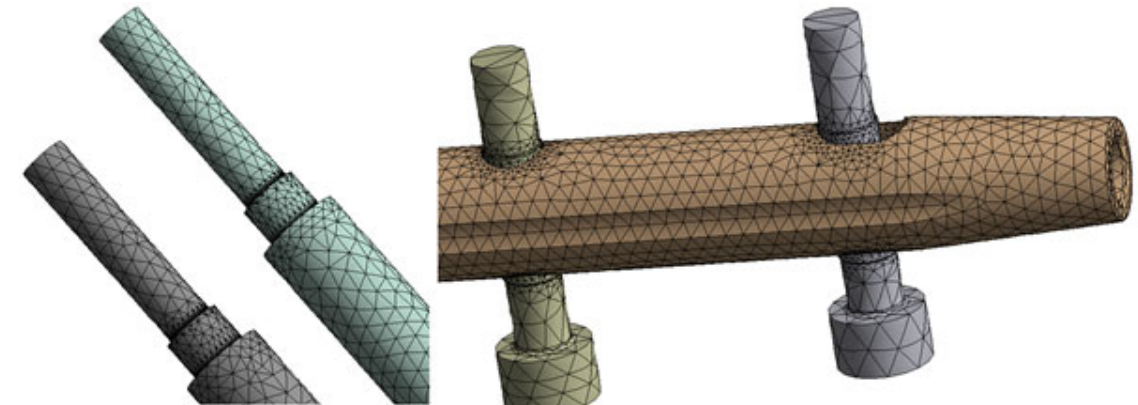
Figure 12. Local mesh refinement for a Medin 125° nail. Table 4. Mesh properties.